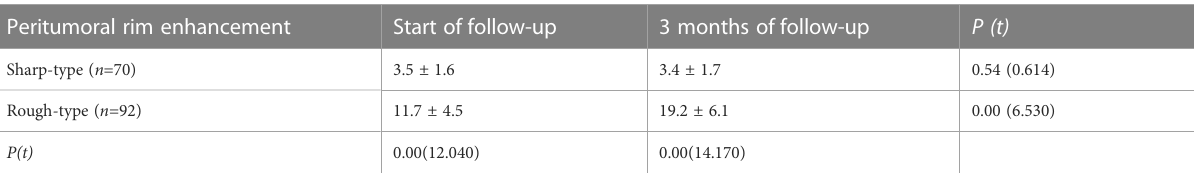
TABLE 3 Comparison of thickness between two types of the peri-tumor edge enhancement by contrast-enhanced MRI in HCC patients after DEB- TACE (mm, (cid:1) x ± s ). Peritumoral rim enhancement